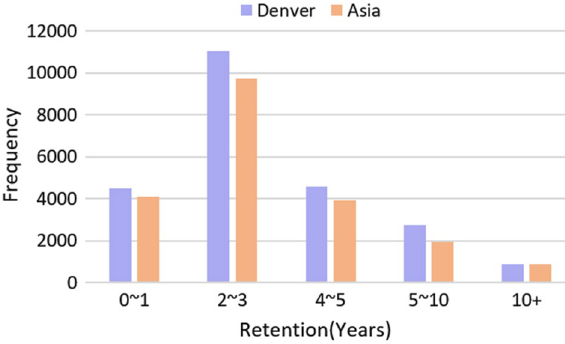
Fig. 3 Retention rate of users in Denver and Asia in our